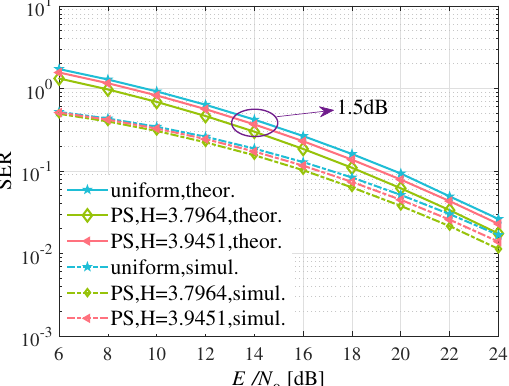
Figure 6. Average SER from Equation (10) and Monte Carlo simulations versus E s / N 0 with or without the PS.